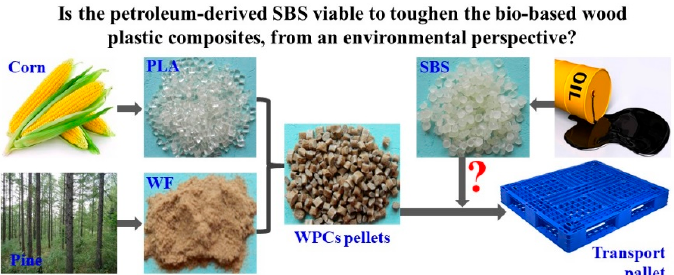
Figure 1. Raw materials and manufacture of the polylactide (PLA)-based wood plastic composites (WPCs) toughened with styrene-butadiene-styrene (SBS).